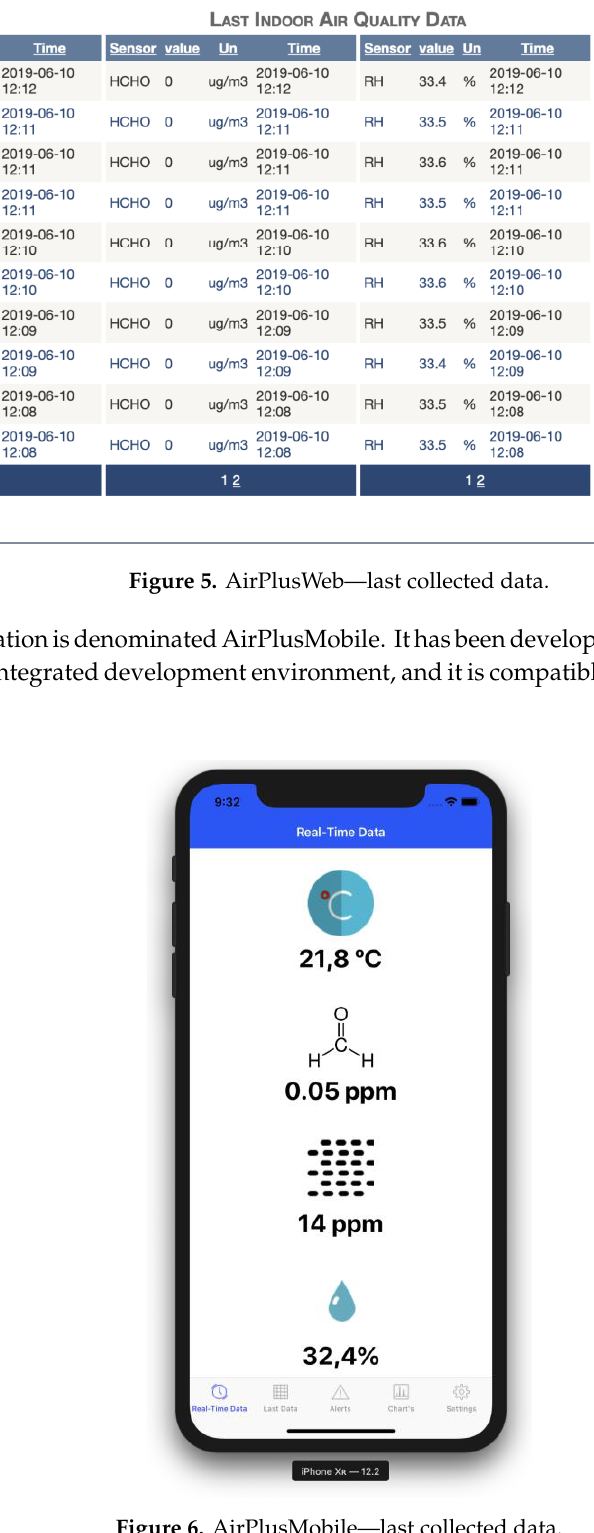
Figure 6. AirPlusMobile — last collected data.